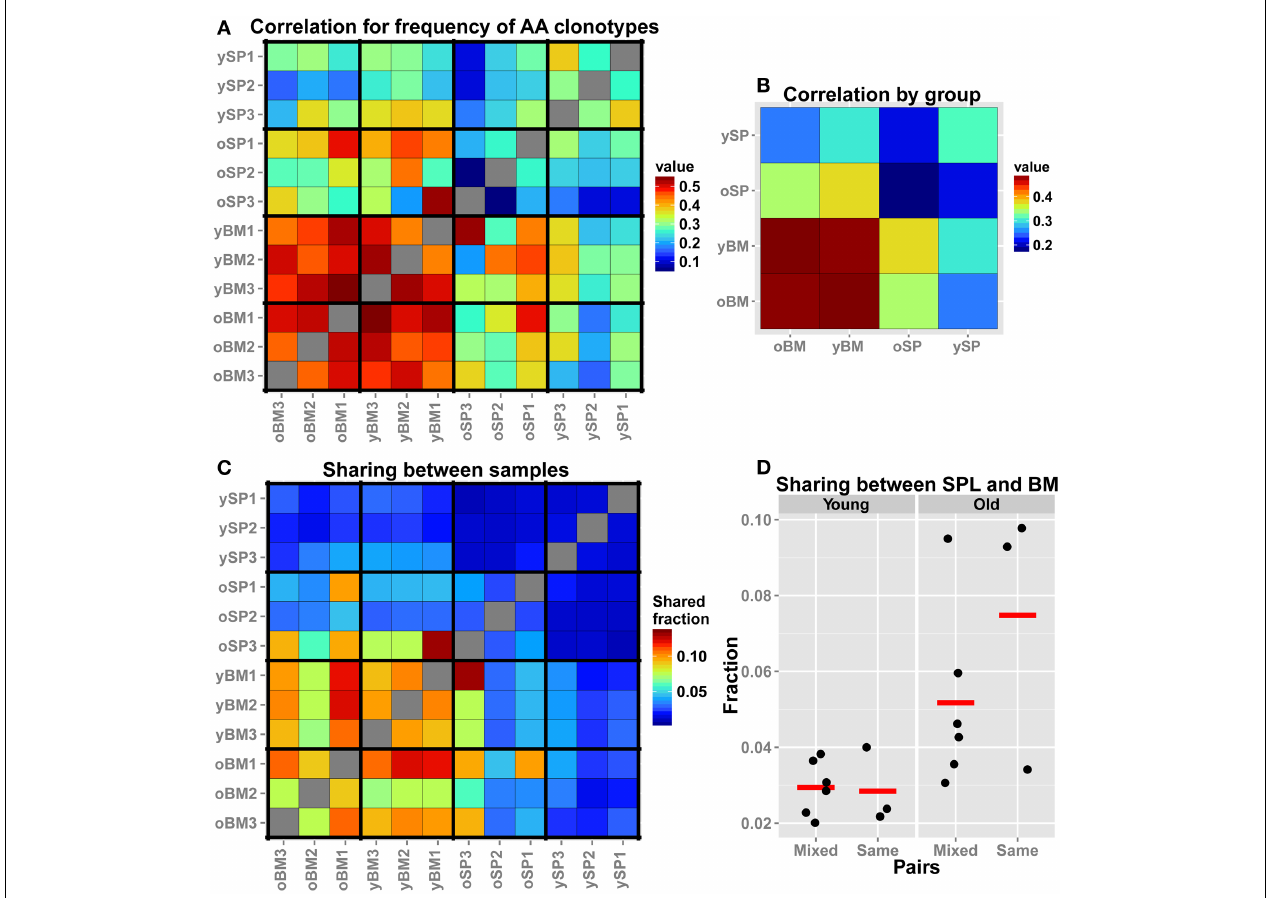
groups and across age is evident. In addition, the repertoire of the old SPL group has a higher correlation with the young BM and old BM groups, and a low intra-group correlation. (C) Sharing of clones between samples. From each sample, we randomly chose 300 AA clones and calculated pairwise sharing.The values represent the fraction of the sample that is shared between any particular pair, averaged over 100 iterations. BM repertoires show high level of sharing between individual mice and across age groups. (D) A comparison of sharing between BM and SPL repertoires within the same animal or from different animals